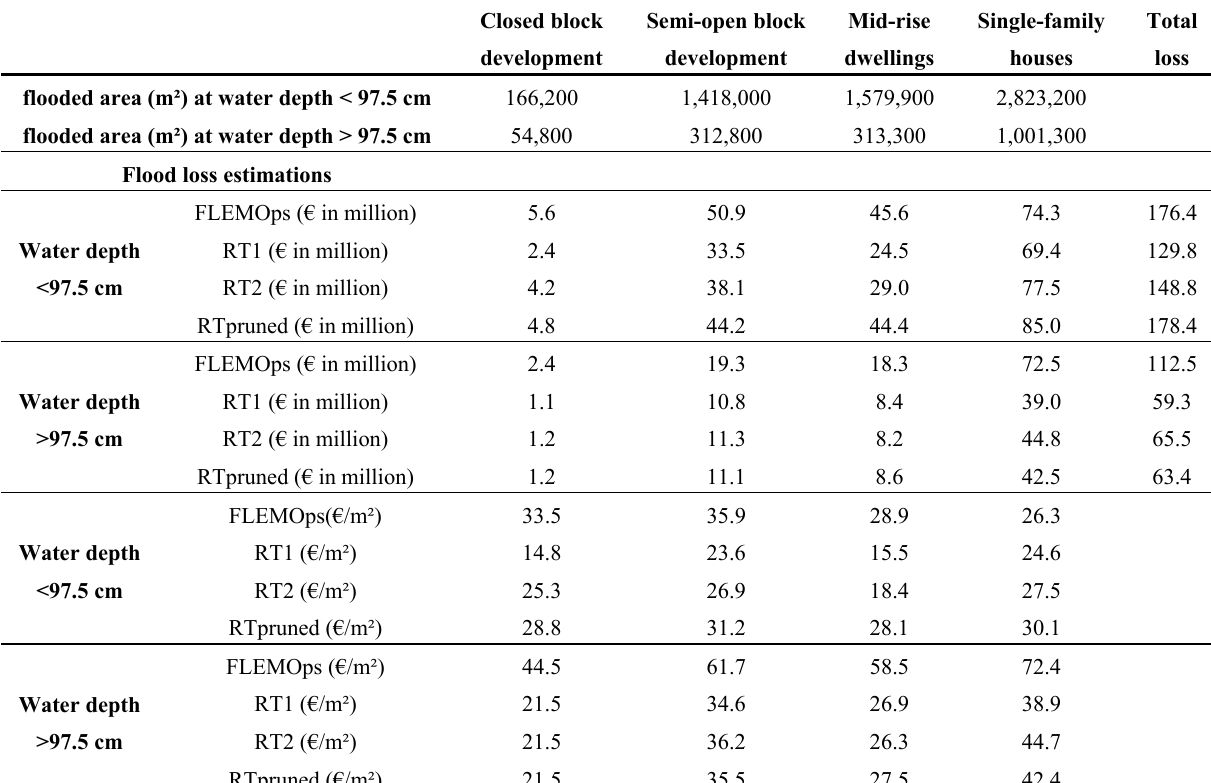
Table 7. Absolute and area-weighted flood losses of the four urban structure types.